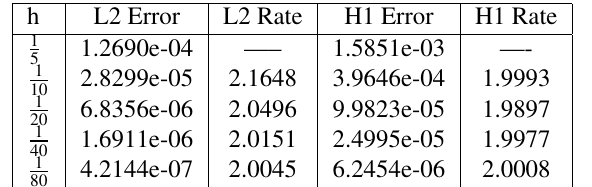
Table 6. Errors for Quadratic IFEM at final time for β + ( x ) = ( x + 1) 2 and β − ( x ) = x 2 + 1, ∆ t = h /